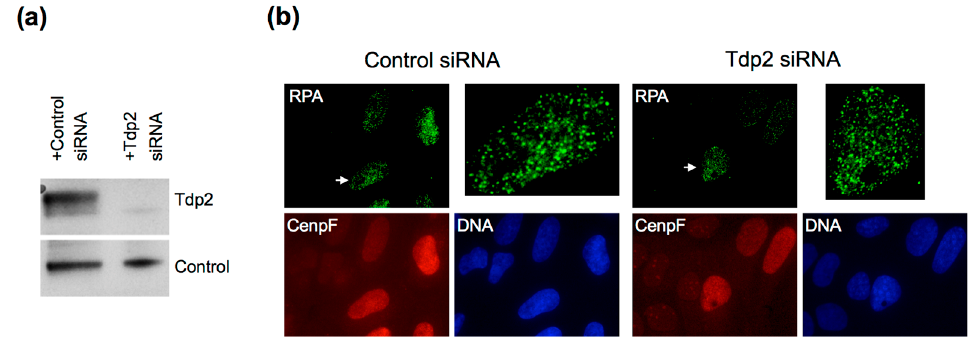
Figure 5. The resection of etoposide-induced DSBs does not require Tdp2. ( a ) Western blot for Tdp2 in U2OS cells treated with Tdp2 siRNAs (sc-60566; Santa Cruz Biotech, Dallas, TX, USA) or control siRNA (D-0012101-03; GE Dharmacon, Lafayette, CO, USA) following the published procedure [44]. Tdp2 was detected with rabbit polyclonal anti-Tdp2 antibodies (Bethyl Laboratories, Montgomery, TX, USA); ( b ) RPA foci induced by etoposide in U2OS cells treated with control siRNA or Tdp2 siRNAs. Cells were exposed to 250 µ M etoposide for 2 h, fixed and stained for RPA, CenpF and DNA as previously described [44]. Close-ups of the nuclei indicated by the arrows are shown on the upper right of each panel.